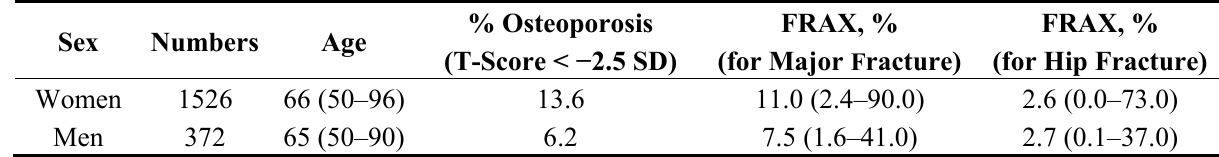
Table 1. Demographic data of a Dutch cohort after a recent fracture.